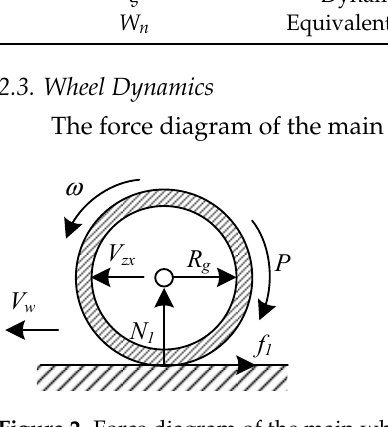
Figure 2. Force diagram of the main wheel.